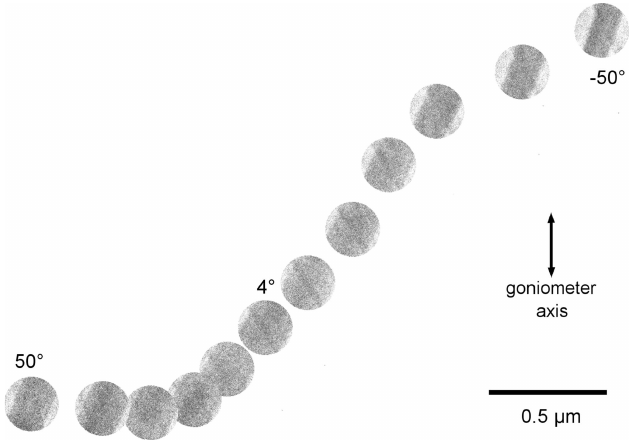
Figure 5 The movement of the crystal during data acquisition for DS4.